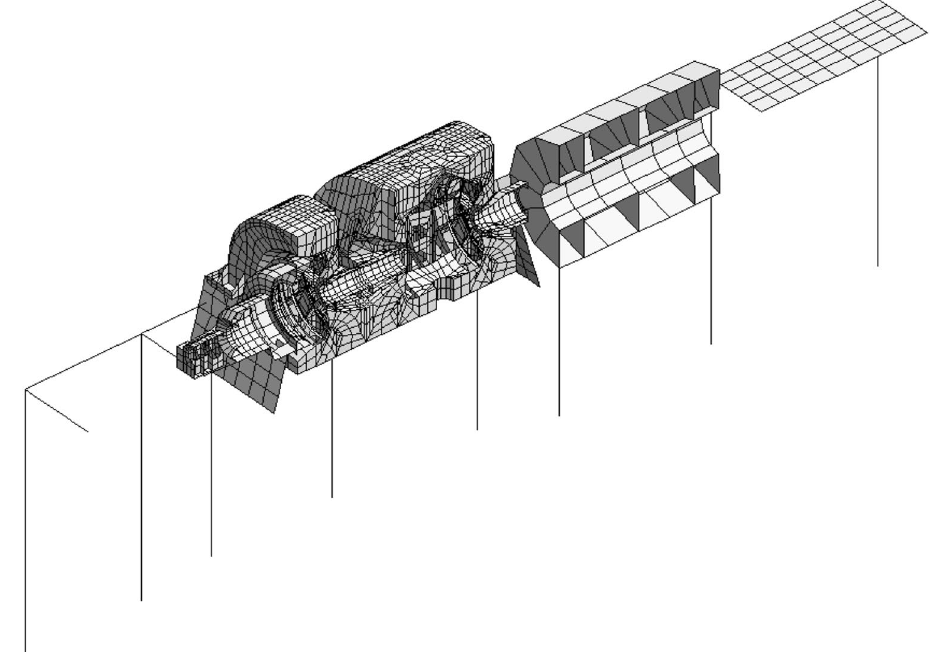
Fig. 10 Model 12, taking into account the stiffness of the generator